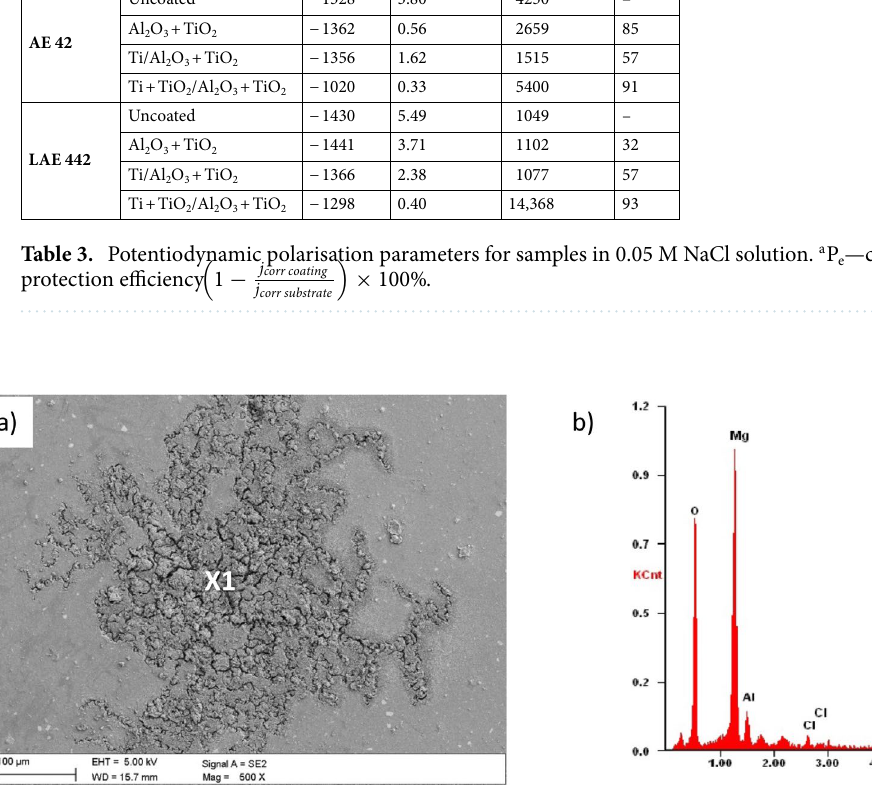
Figure 10. ( a ) Surface morphology after an electrochemical examination of the uncoated LAE442 sample, ( b ) X-ray energy dispersive plot of the area X1 shown in ( a ).